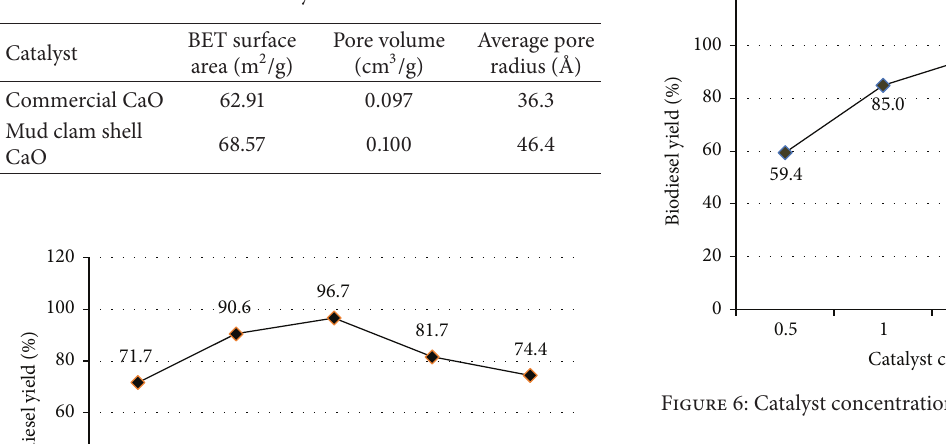
Table 2: Catalyst BET result.